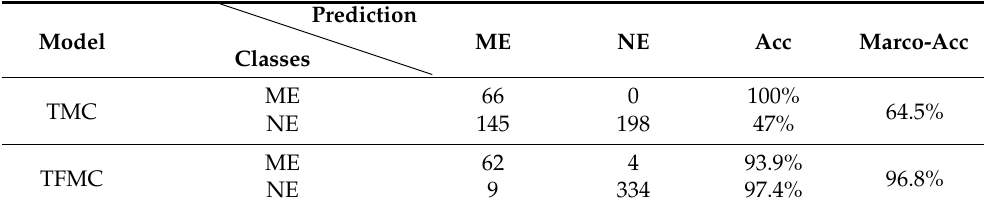
Table 11. Comparison of TFMC method and TMC method on the classification of events; each event consists of six